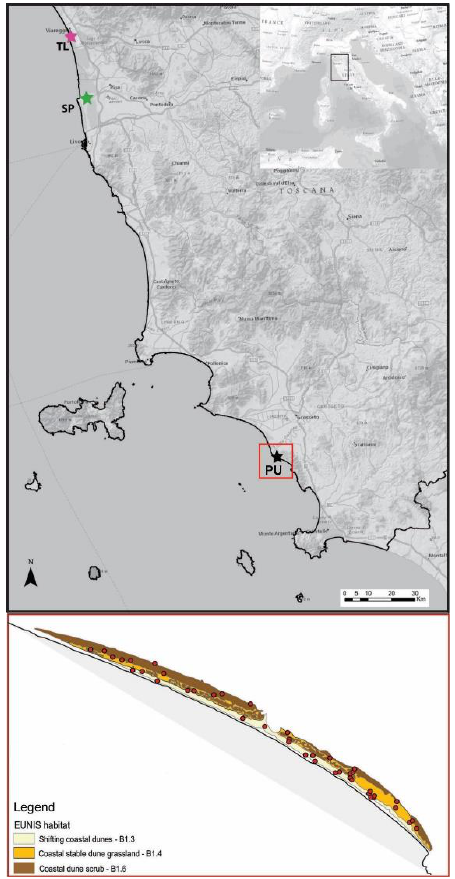
Figure 1. Locations of the Special Areas of Conservation (SACs) on the Tyrrhenian coast of Tuscany (colored stars) with respect to the Italian peninsula (upper right insert). Lower panel shows an example from a portion of the SAC “Dune costiere del Parco dell’ Uccellina” with European Nature Information System (EUNIS) habitats, red points indicate plots.